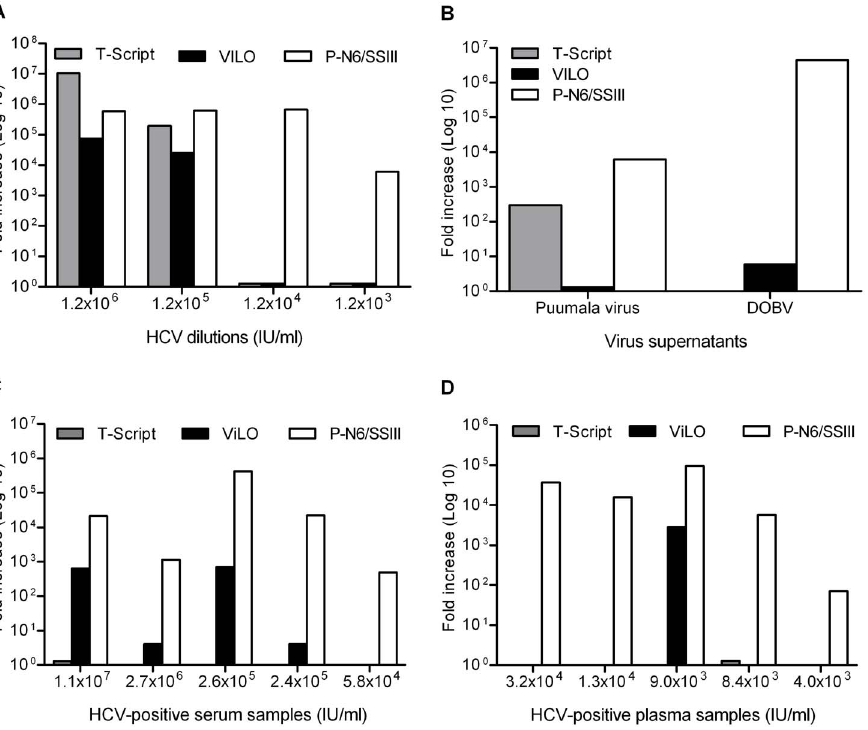
Figure 1. Improved WT amplification when using 5 9 -phosphorylated random hexamers in RT-reaction. Comparison of three different RT-reactions in the Whole Transcriptome Amplification (WTA) protocol. Purified viral RNA was amplified by WTA using VILO, T-Script or P-N6/SSIII RT- reaction. Virus-specific real-time PCR was performed before and after the amplification step, and fold increase was calculated using D C t -values and dilution factors for each sample tested. (A) WTA-protocols tested with a 10-fold serial dilution of an HCV-positive serum sample with known concentration. (B) WTA-protocols tested with two different virus-positive cell culture supernatants, Puumala virus and Dobrava-Belgrade virus (DOBV), respectively. (C) WTA-protocols tested with five HCV-positive serum samples with estimated concentration (IU/ml). (D) WTA-protocols tested with five HCV-positive plasma samples with estimated concentration (IU/ml).